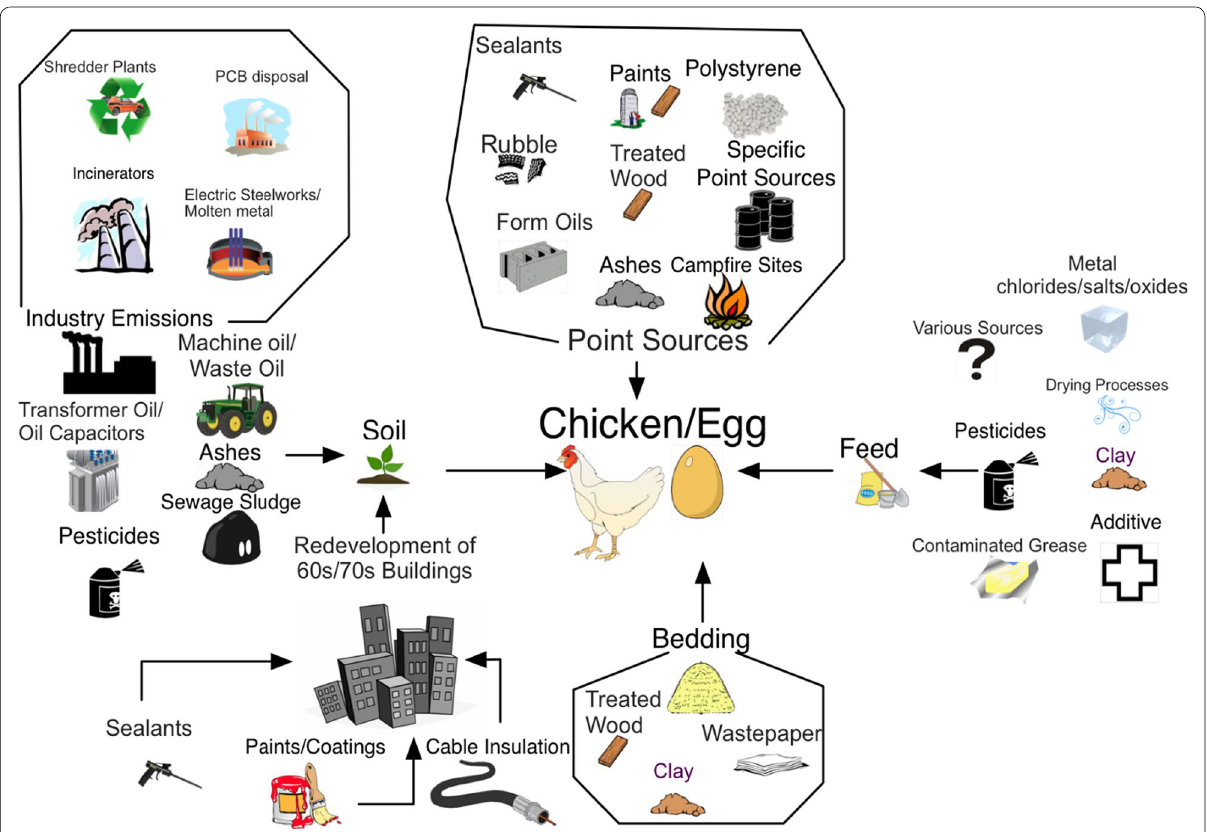
Fig. 1 PCB and PCDD/F exposure sources for